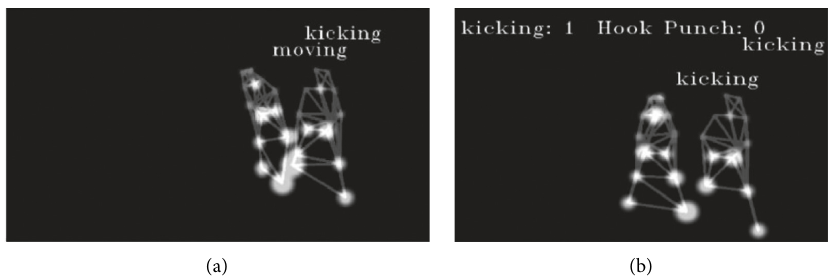
Figure 8: Video tactical intelligence analysis; (a) behavior visualization renderings; (b) statistics of technical action